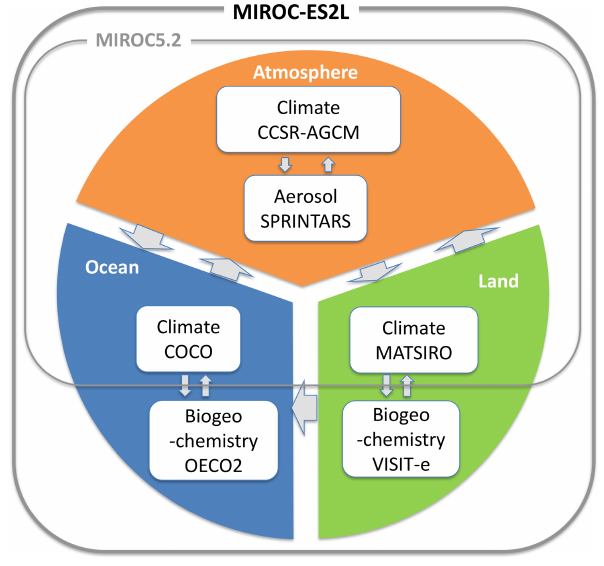
Figure 1. Schematic of MIROC-ES2L.